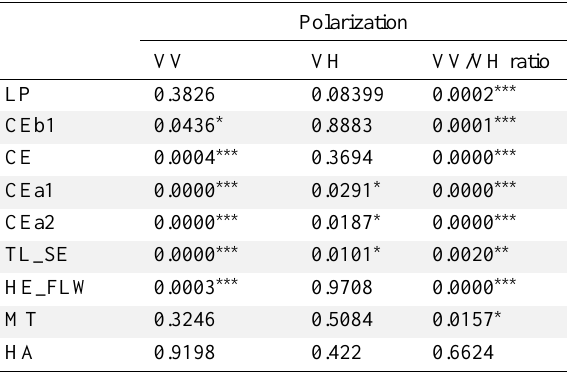
Table 4. Mann-Whitney U test results: p-values between transplanted (TP) and direct seeded (WDS) rice for every crop growth stages. n : TP=136, WDS=50 Land preparation (LP), one acquisition before crop establishment (CEb1), crop establishment (CE), one acquisition after CE (CEa1), two acquisitions after CE (CEa2), tillering- stem elongation (TL_SE), heading-flowering (HE_FLW), maturity (MT), and harvesting